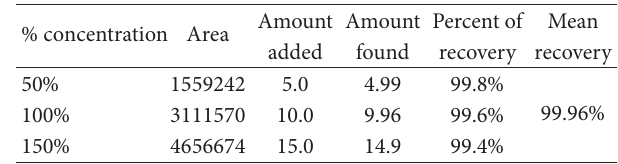
T 2: Accuracy of the proposed method.